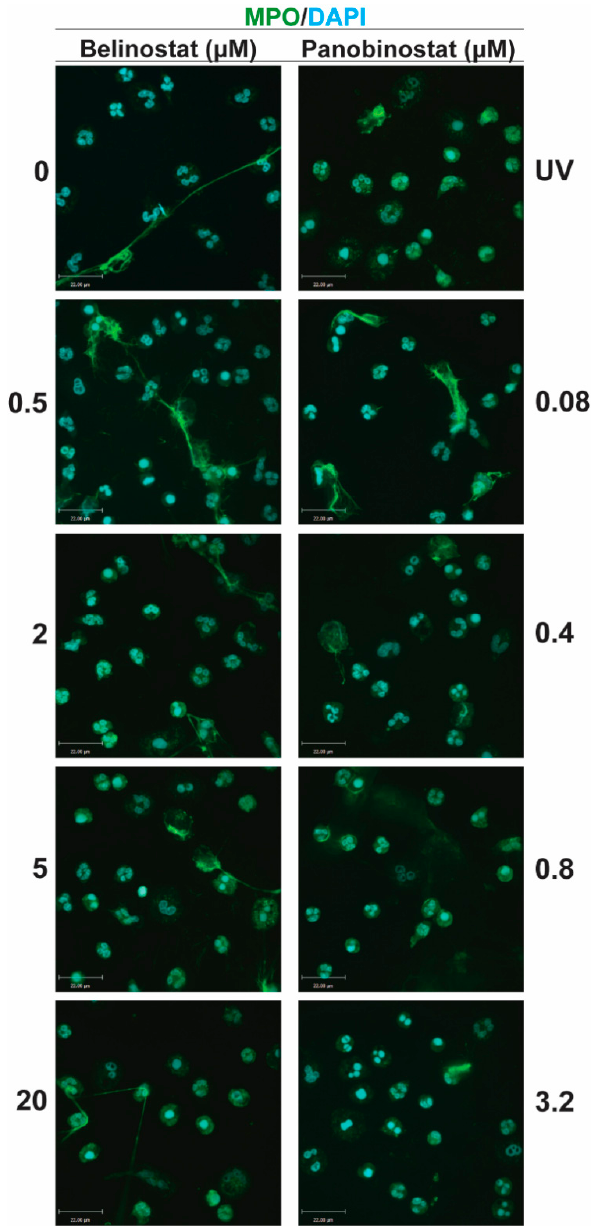
Figure 4. Confocal microscopy images confirm that HDACis inhibit baseline NETosis. Neutrophils were treated with negative control (RPMI), positive control (UV; 0.24 J/cm 2 ) or HDACis (0.5, 2, 5 and 20 µM belinostat; 0.08, 0.4, 0.8 and 3.2 µM panobinostat) for 120 min. Cells were then imaged after being fixed and immunostained for myeloperoxidase (MPO) and DNA (DAPI). Neutrophils treated with RPMI show typical polymorphonuclear morphology of neutrophils. When treated with 0.5 µM belinostat or 0.08 µM panobinostat, neutrophils show increased levels of NETosis. However, cells treated with increased concentrations of HDACis decreased MPO colocalization with DNA and